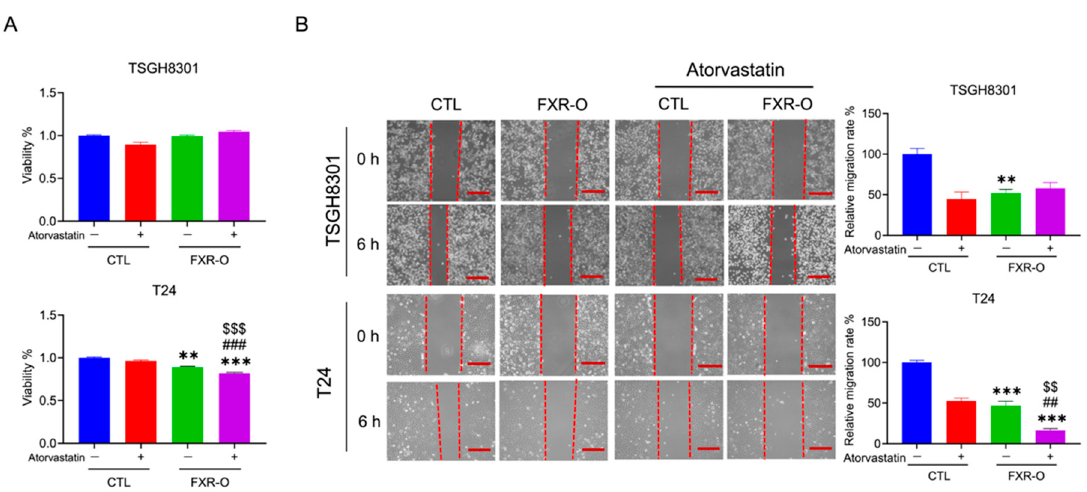
Figure 6. The effect of FXR overexpression combined with atorvastatin treatment on survival and migration. ( A ) The viability of FXR-O TSGH8301 and T24 cells treated with or without atorvastatin (20 µM) was examined by MTT assays for 24 h. ( B ) Wound healing migration assays were performed in control and FXR-O TSGH8301 and T24 cells treated with or without atorvastatin. The lower panel shows the quantified relative migration rate. ** p < 0.01; *** p < 0.001 compared to the control group. ## p < 0.01, ### p < 0.001 compared to the control + atorvastatin group. $$ p < 0.01; $$$ p < 0.001 compared to the FXR-O group. Scale bar = 200 µm.